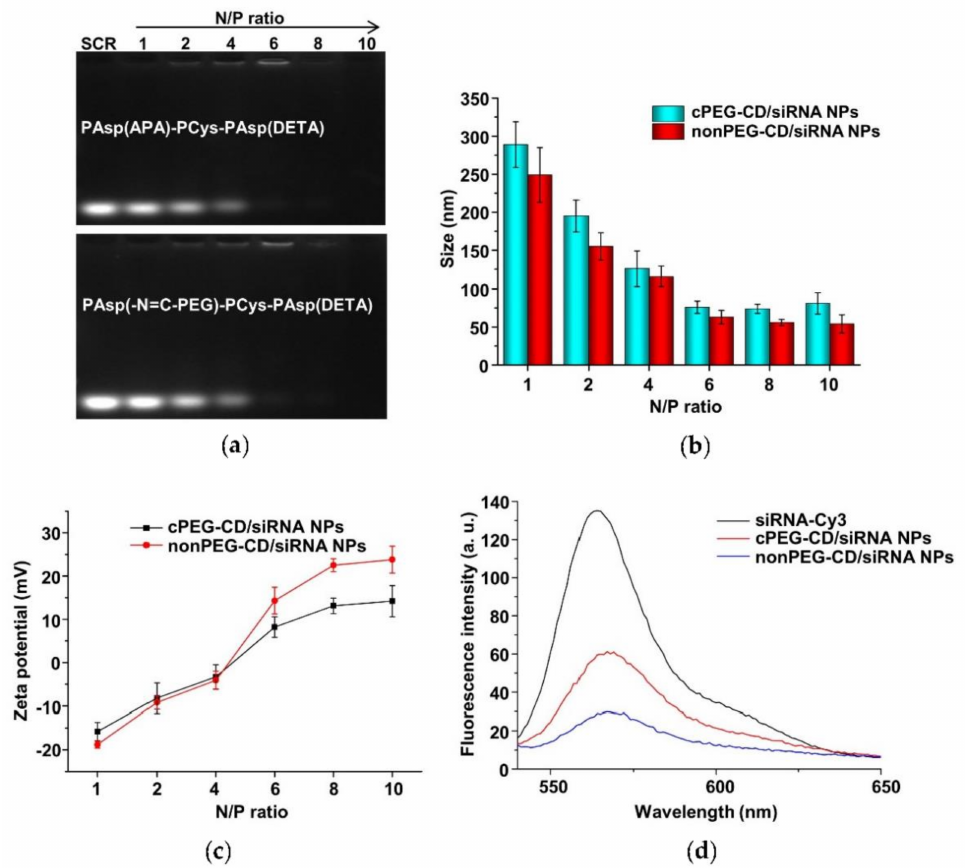
Figure 11. ( a ) Electrophoretic mobility of scrambled siRNA (SCR) in agarose gel after complexation with PAsp(-N=C-PEG)-PCys-PAsp(DETA) and PAsp(APA)-PCys-PAsp(DETA) at various N/P ratios. Particle sizes ( b ) and zeta potentials ( c ) of cPEG-CD/siRNA NPs and nonPEG-CD/siRNA NPs at various N/P ratios and pH 7.4. Data are shown as the mean ± SD (n = 3). ( d ) Fluorescence profiles of siRNA-Cy3, cPEG-CD/siRNA-Cy3 NPs and nonPEG-CD/siRNA-Cy3